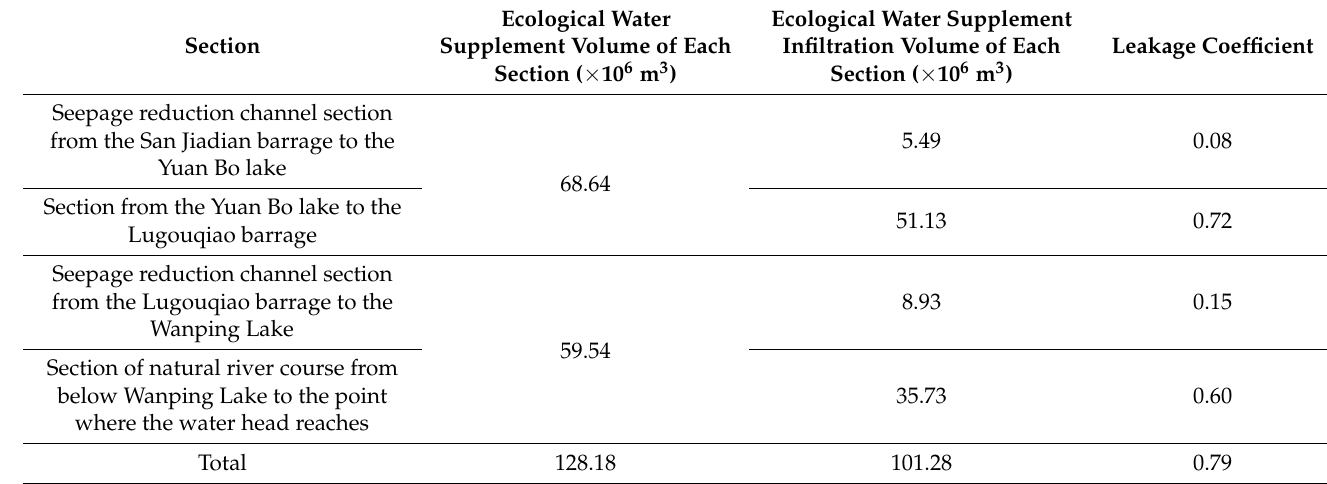
Table 3. Ecological water supplement infiltration volume and leakage coefficient for each section of Yongding River in